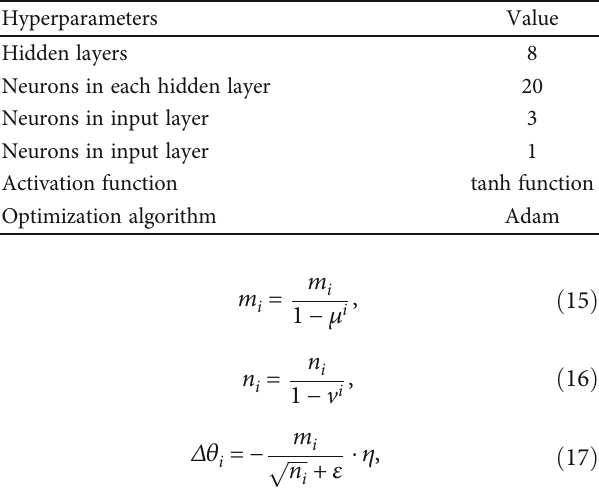
Table 2: Speci fi c setting of the PINN